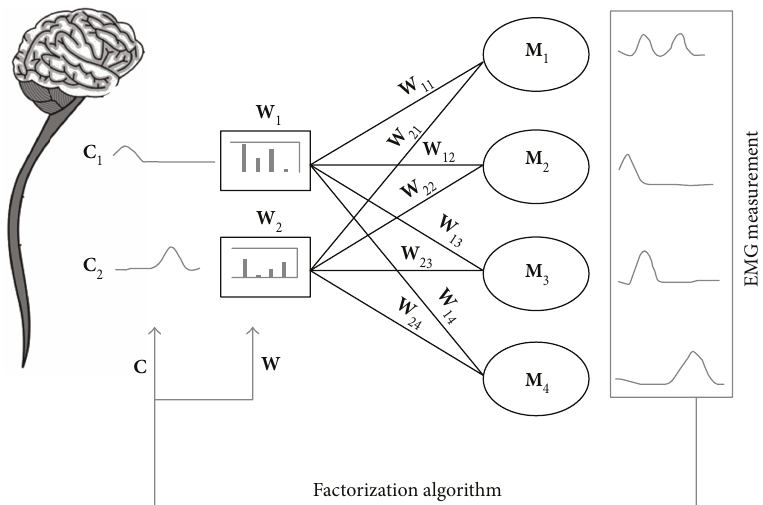
Figure 1: Synchronous muscle synergy model. In this graphical example, two di ff erent commands C , indicating the temporal activation coe ffi cients, are sent to the mixing matrix W , consisting of four synergy vectors. The single command C i is distributed to the muscle M j according to the muscle weighting W ij . The inverse problem to be solved by a factorization algorithm is the accurate identi fi cation of the underlying structures W and C starting from the measurement of D